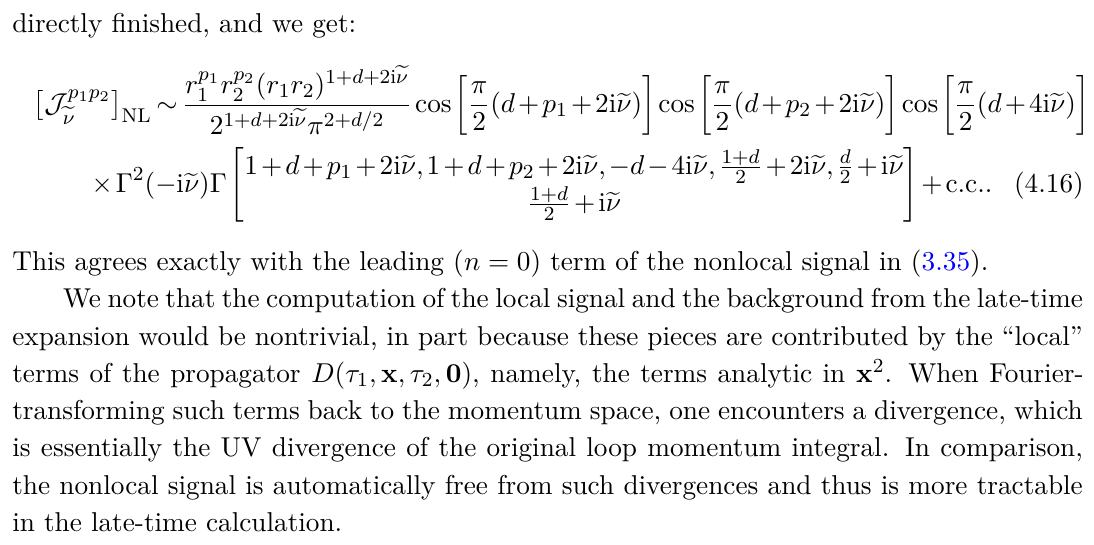
(blue) separately. In each of the BG = p = − 2 , r = 0 . 3 , and ν = 2 . 1 2 2 e